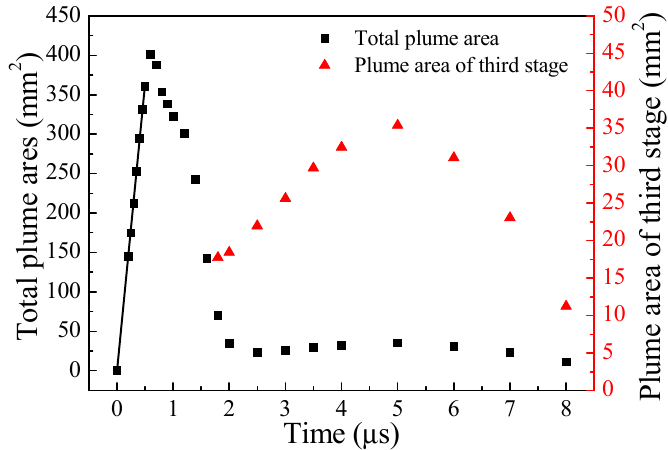
Figure 7. The variation of the total plume area and the third stage plume area with time at ambient pressure 0.005 Pa and laser energy 542.3 mJ.